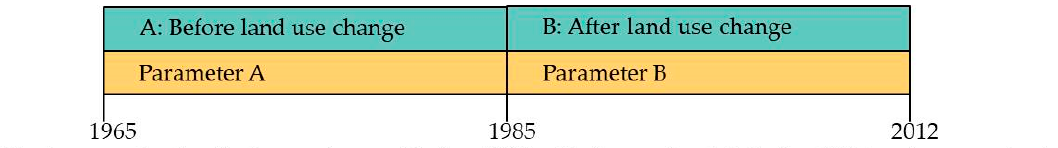
Figure 5. The data Figure 5. The data processing.